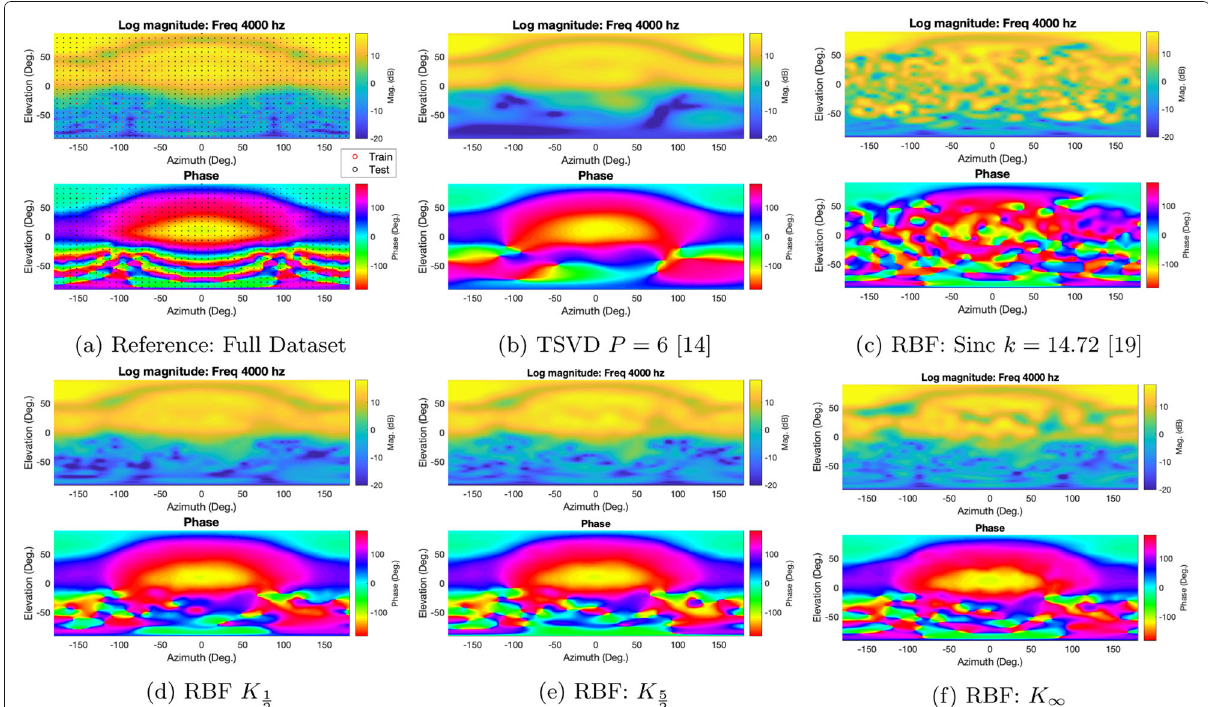
Fig. 4 Sample model fit and inferences are shown for far-field speaker responses by TSVD SH bases and RBF kernels under 4-fold cross-validation. TSVD bias-variance is sensitive to max-order P whereas RBFs are sensitive to the kernel function sharpness; K 1 sinc too sharp